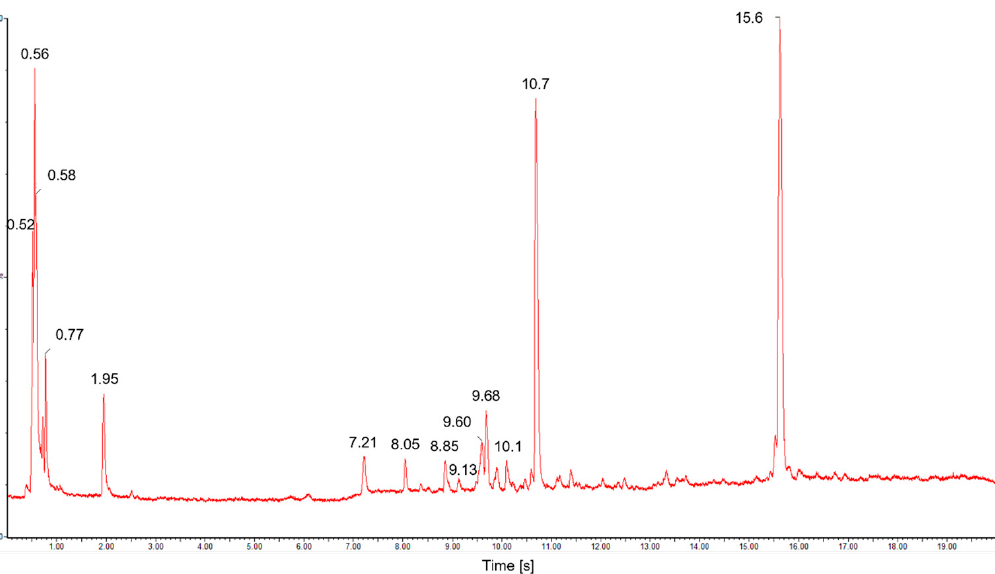
Figure 2. Peak chromatogram for mucilage extracted from Opuntia-ficus fruit peels obtained by UPLC-QTOF-MS.